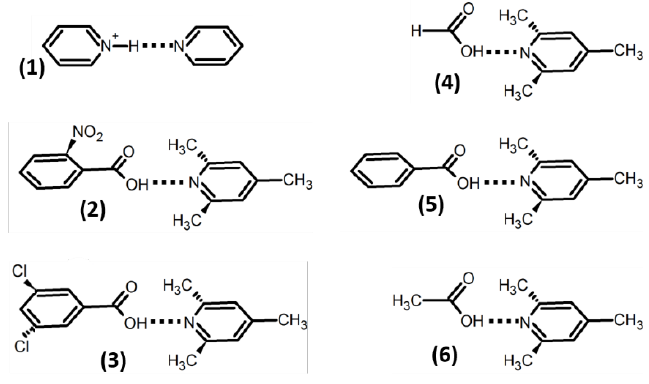
Figure 2. H-bonded complexes studied in this paper: proton-bound homodimer of pyridine ( 1 ) and complexes of 2,4,6-trimethylpyridine (collidine) with 2-nitrobenzoic acid ( 2 ), 3,5-dichlorobenzoic acid ( 3 ), formic acid ( 4 ), benzoic acid ( 5 ), and acetic acid ( 6 ).